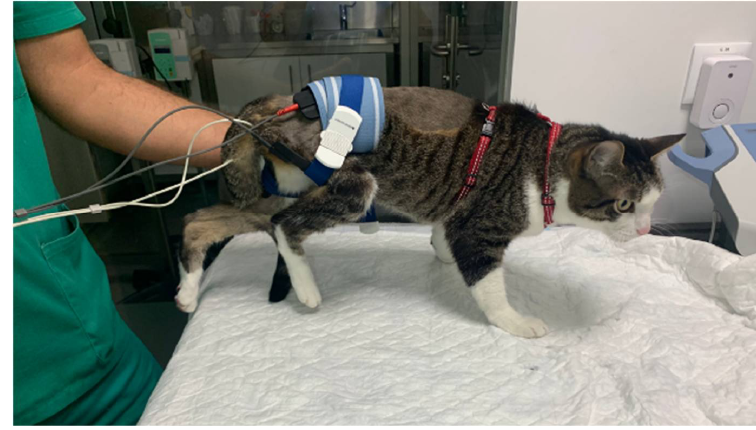
Figure 3. Functional electrical segmental stimulation of the sciatic nerve.